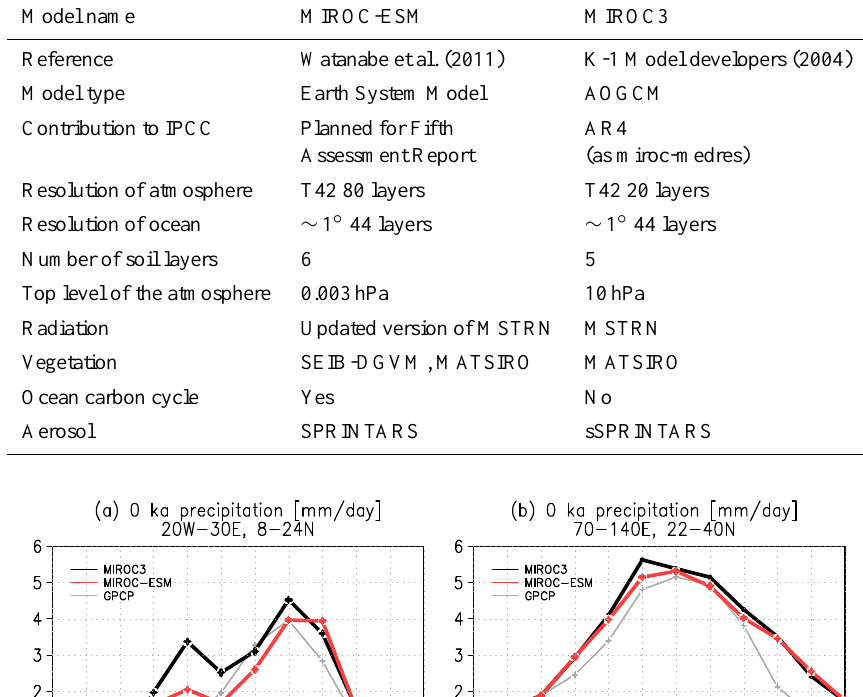
Table 2. Model comparison of MIROC-ESM and MIROC3.